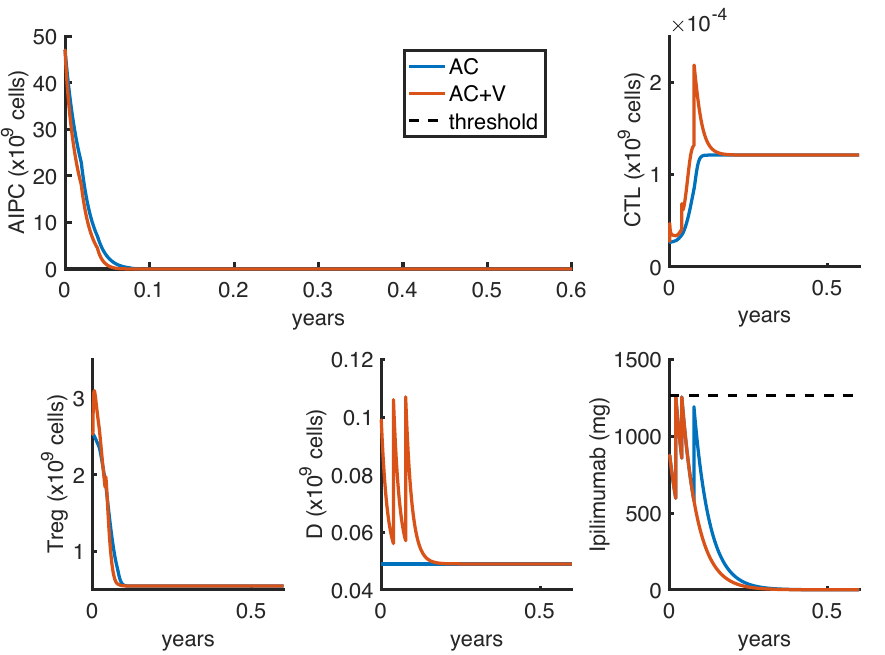
Figure 3. Administration protocol as result of the optimization problem OP1, with ∆ t = 1 week. Blue